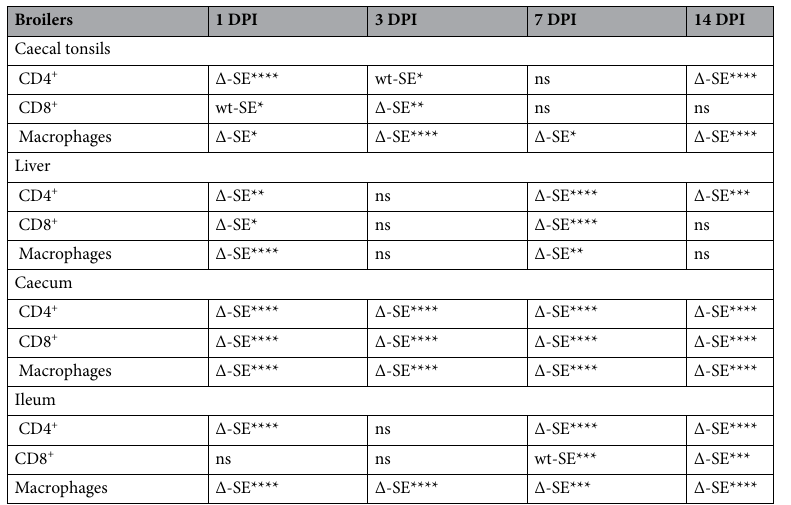
Table 1. Representation of the significant difference related to the quantitative distribution of different immune response cells in organs of broilers infected with Salmonella Enteritidis wild and mutant strains